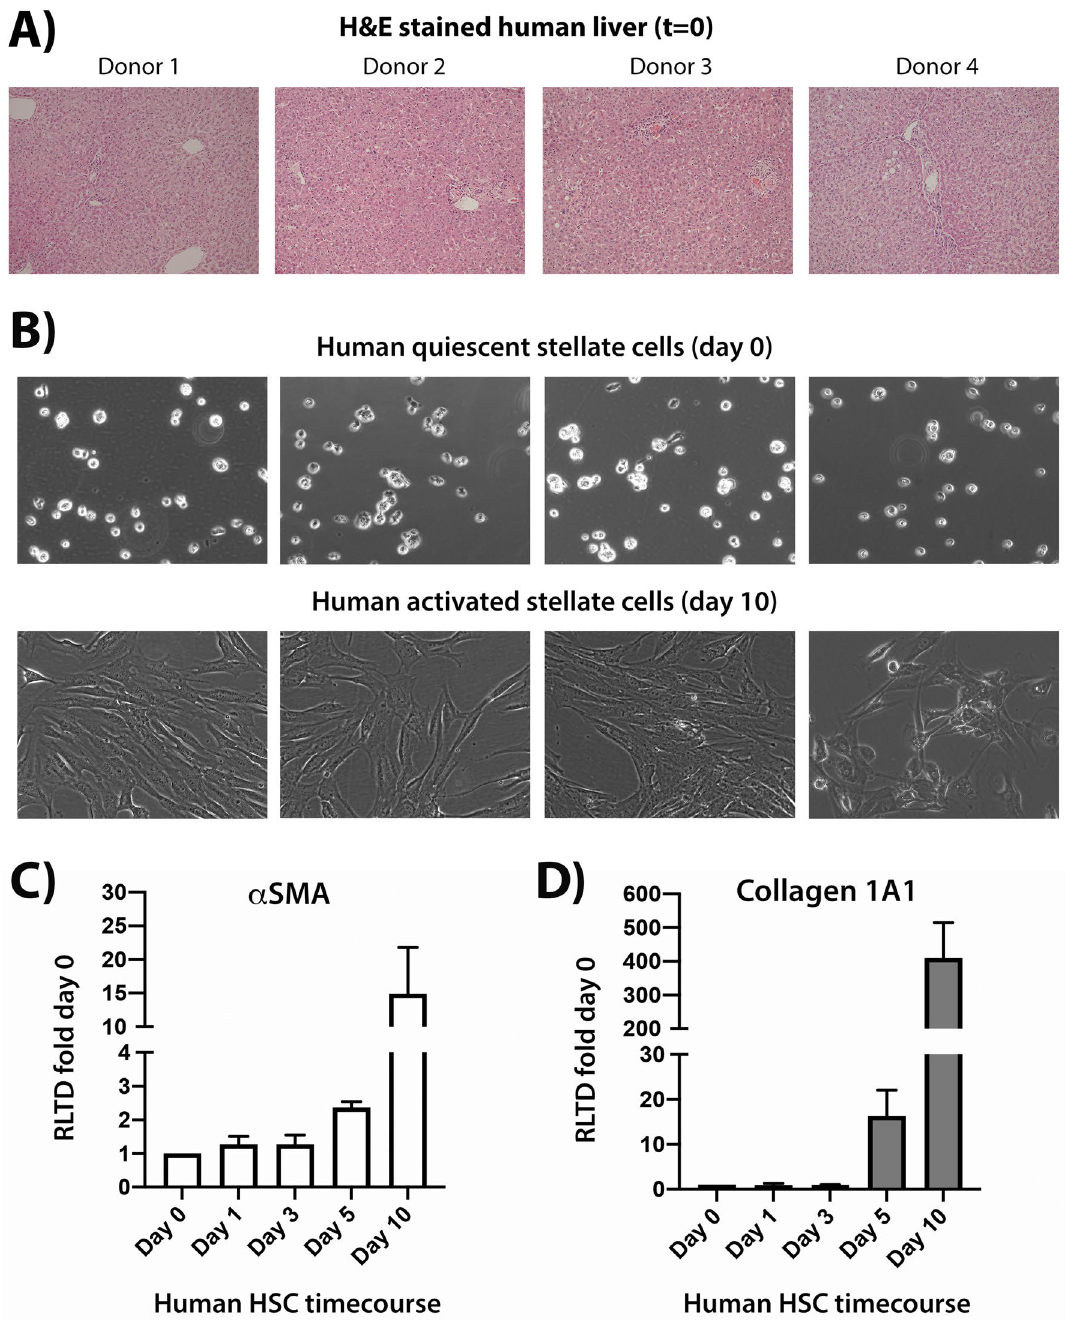
Figure 1. Human HSC isolated from normal human livers and timecourse of their in vitro activation. ( A ) Representative brightfield H&E stained images of four human donor livers used in the study, which depict normal tissue structure and architecture at X10 magnification. ( B ) Representative brightfield images of four human HSC preps used in the study showing quiescent HSC in top panel and fully activated HSC in the bottom panel. ( C ) Quantitative PCR carried out on time-course cDNA isolated from of human HSC preps used in the study showing αSMA transcript levels in ( C ) and Collagen1A1 in ( D